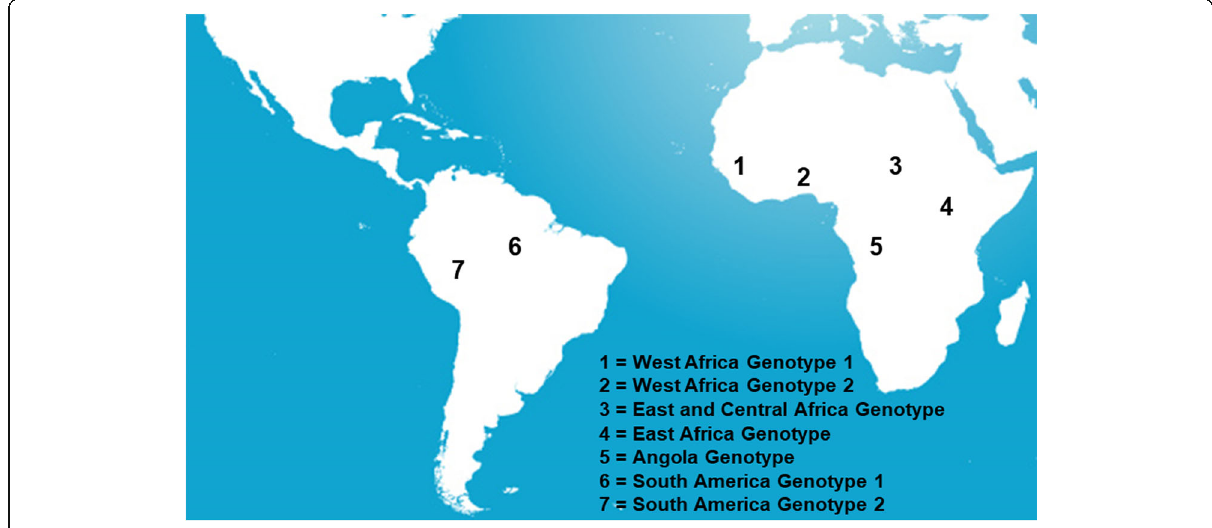
Fig. 4 Yellow fever genotypes (adapted from [30, 31, 85 – 87, 89,